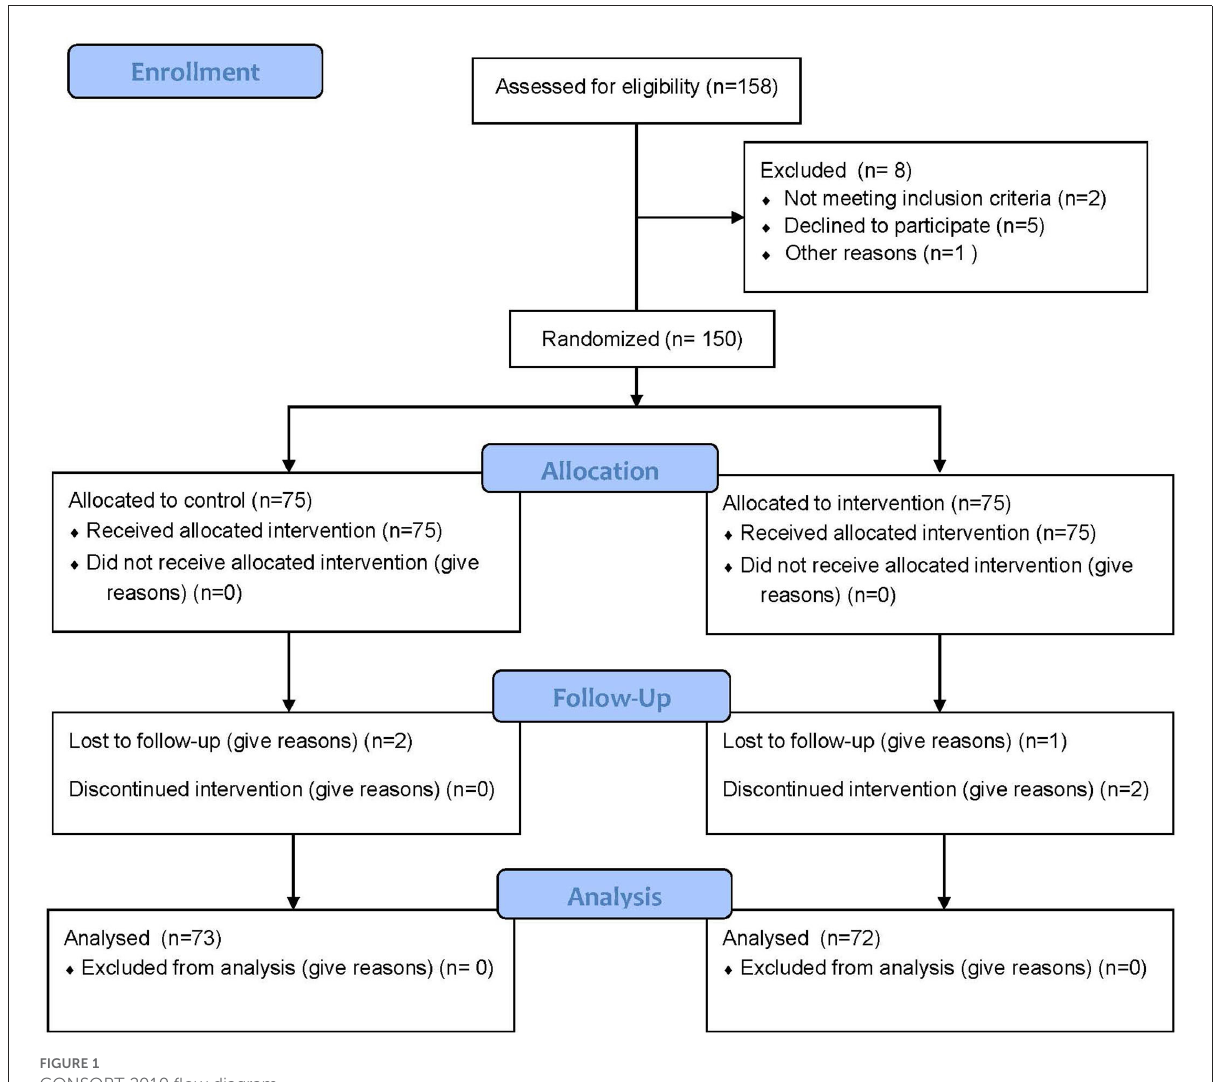
FIGURE1 CONSORT 2010 flow